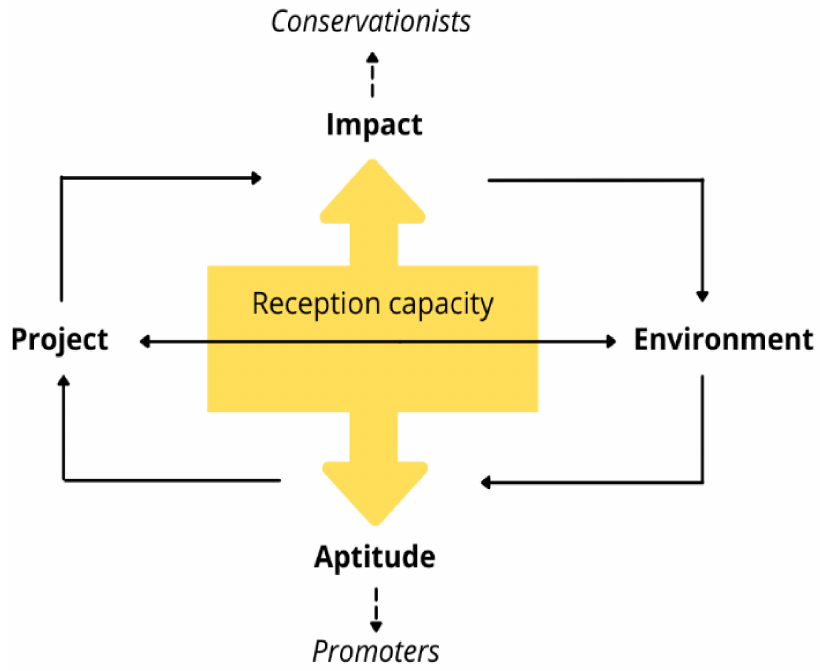
Figure 4. Relationship between the project and the environment, considering the existing reception capacity. Adapted from